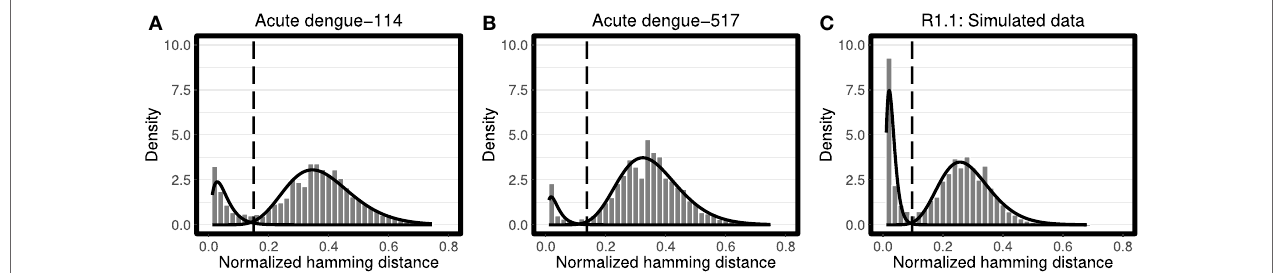
FIGURe 1 | Analysis of the distance-to-nearest neighbor plot to define the distance threshold for partitioning clones. For each sequence, the length-normalized nucleotide Hamming distance to every other sequence was calculated, and the nearest (non-identical) neighbor was identified. The histogram of nearest neighbor distances is fitted using Gamma distribution for both modes (solid line) for (A,B) representative peripheral blood B cell samples from patients with acute dengue virus infection (10), and (C) representative simulated data from Gupta et al. (4). For each data set the optimum threshold, where the average of sensitivity and specificity reaches its maximum, was calculated by the findThreshold function (dashed vertical line). Note that the choice of bin size impacts the shape of plotted histograms, while the fitting procedure is independent of this bin